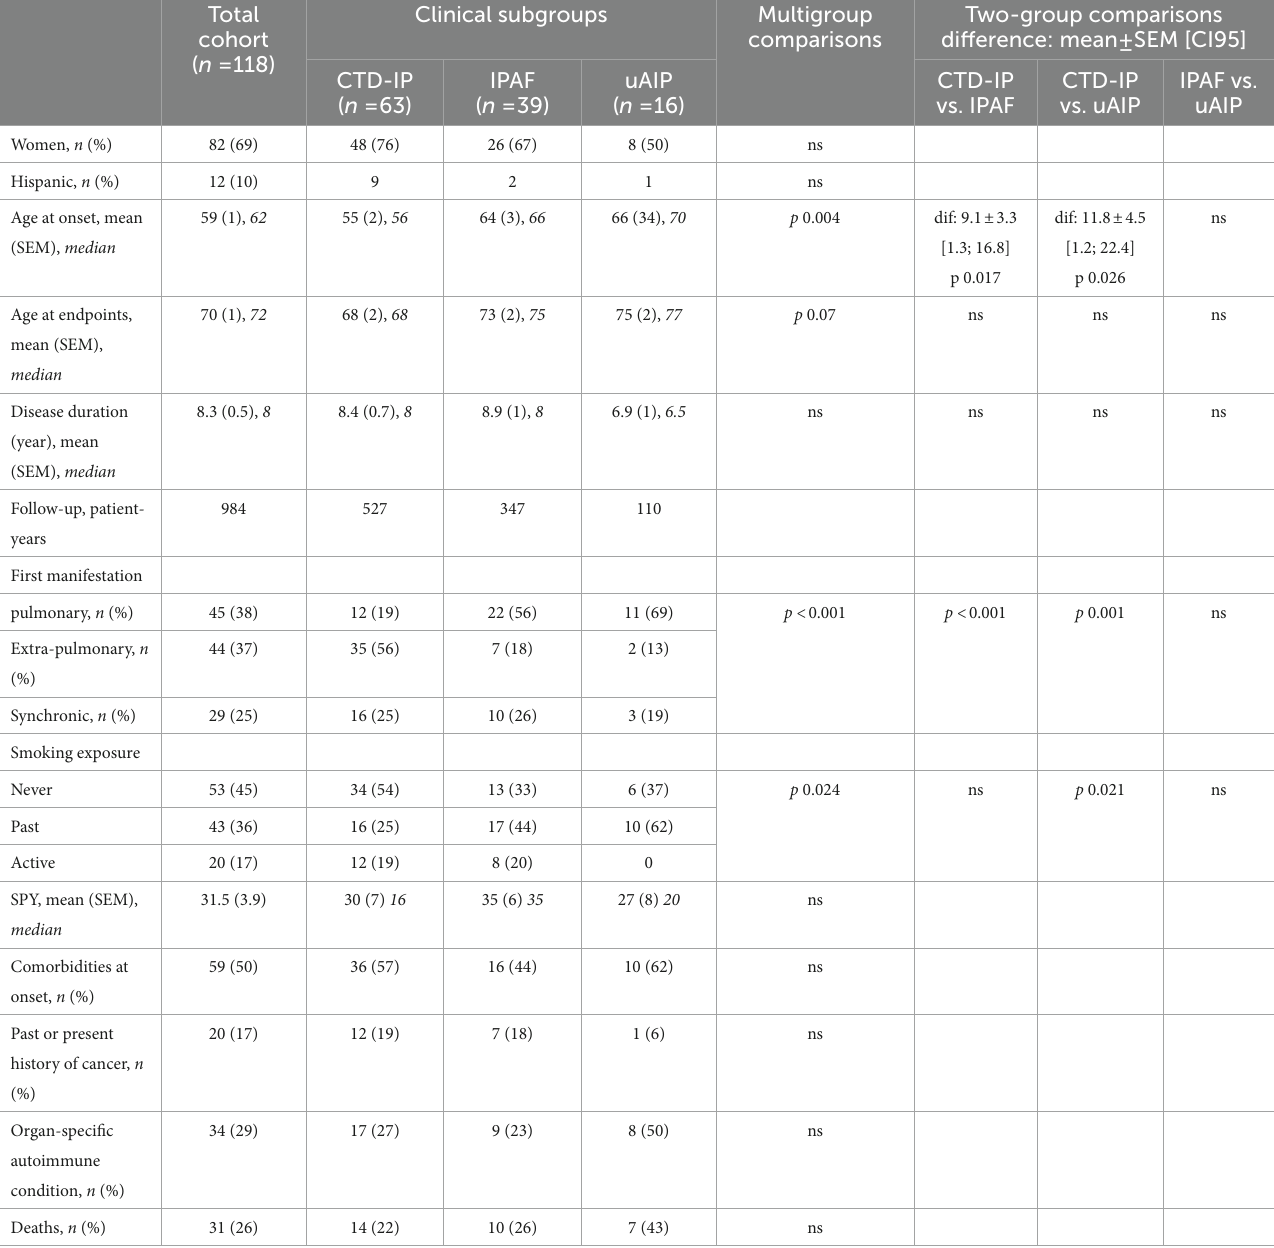
TABLE 1 Study population. All patients were diagnosed with autoimmune interstitial pneumonia. Clinical